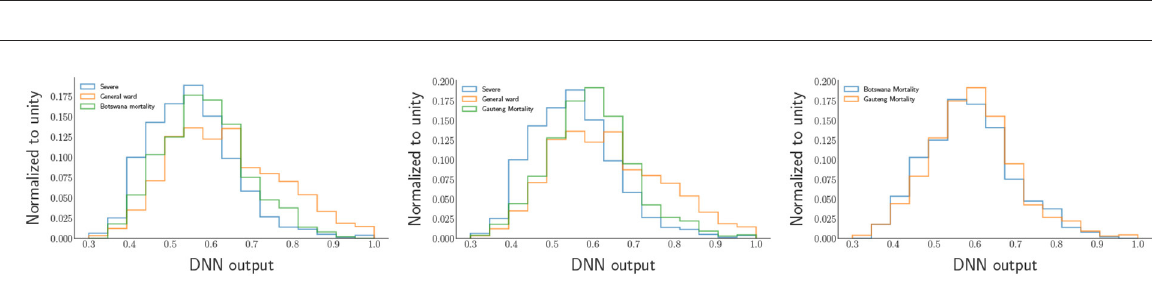
FIGURE11 The DNN output distributions for Mortality behind COVID-19. The distribution on the left represents the mortality of Botswana, and the one on the right represents the mortality of Gauteng (South